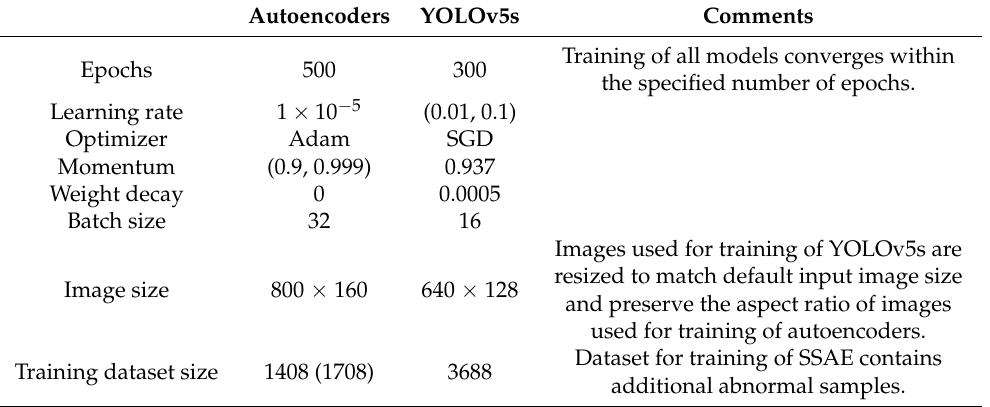
Table 3. Training